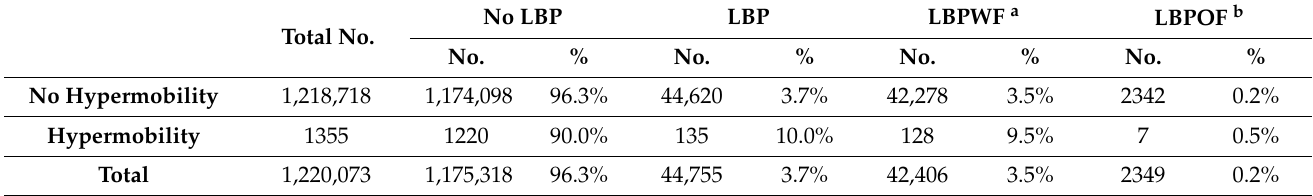
Table 1. Symptomatic Joints Hypermobility and Low Back Pain Prevalence in Adolescents.